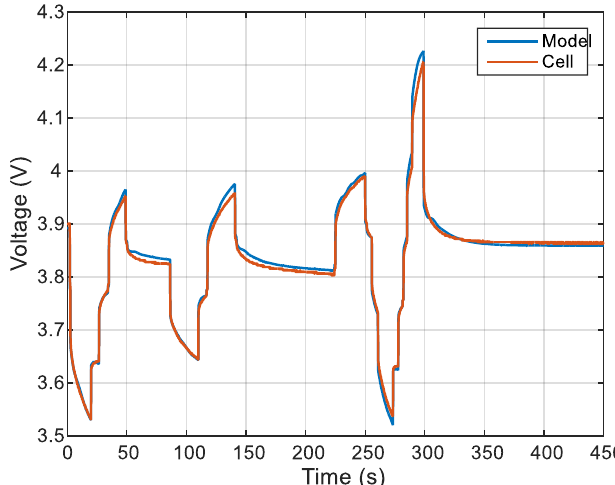
Figure 10. Comparison of the cell voltage and the voltage provided by the model.